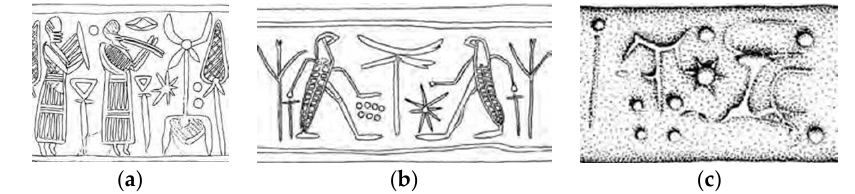
Figure 4. Cylinder seals with crescent moon standards: ( a ) Nebo 1; ( b ) Tall al-Mazar 23; ( c ) Tall al- ʿ Umeiri 78.